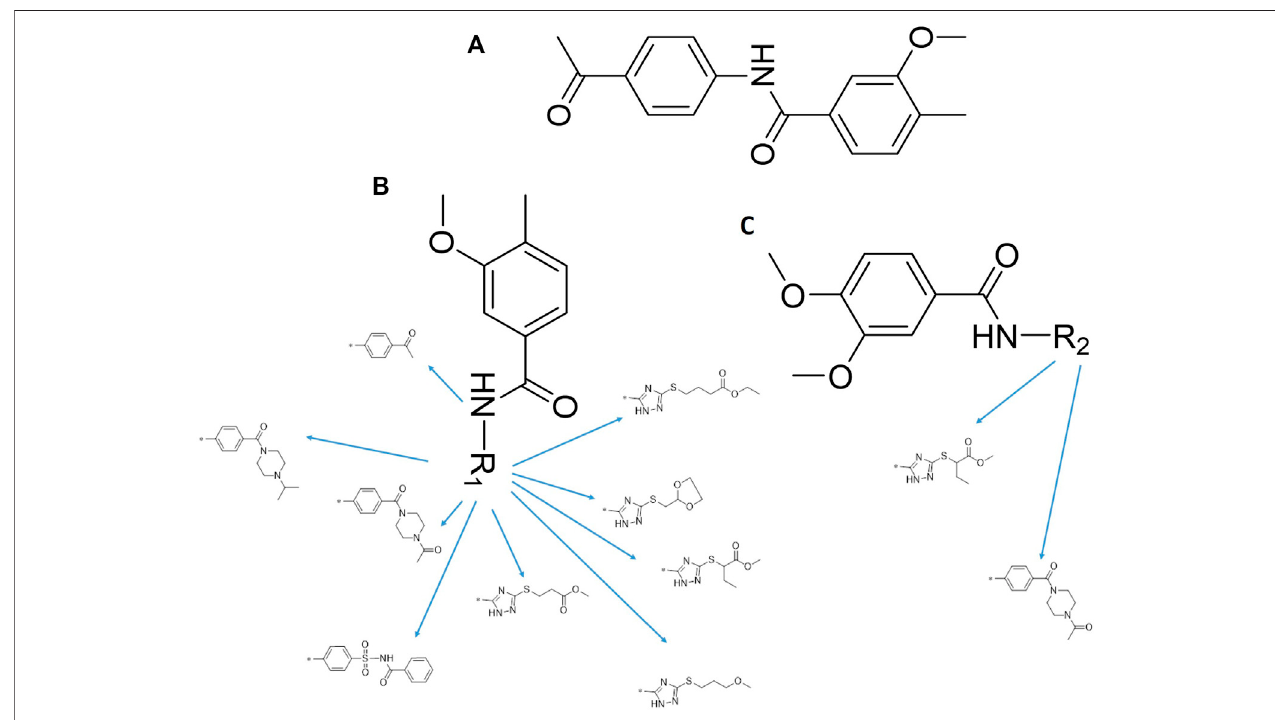
FIGURE 3 | Leading inhibitory DNMT-1 compound. (A) Structure of the leading compound. (B,C) R1 and R2 positions for leading compound substitutions.